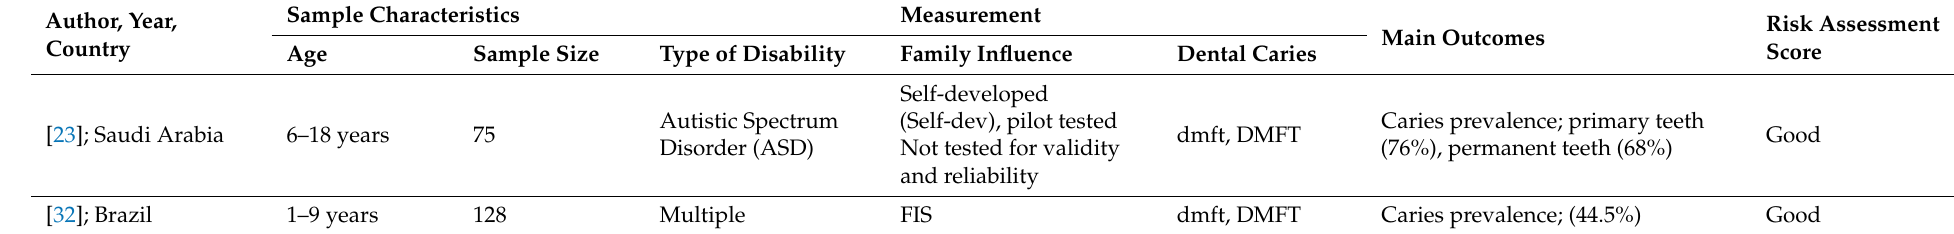
Table 1. Summary of included